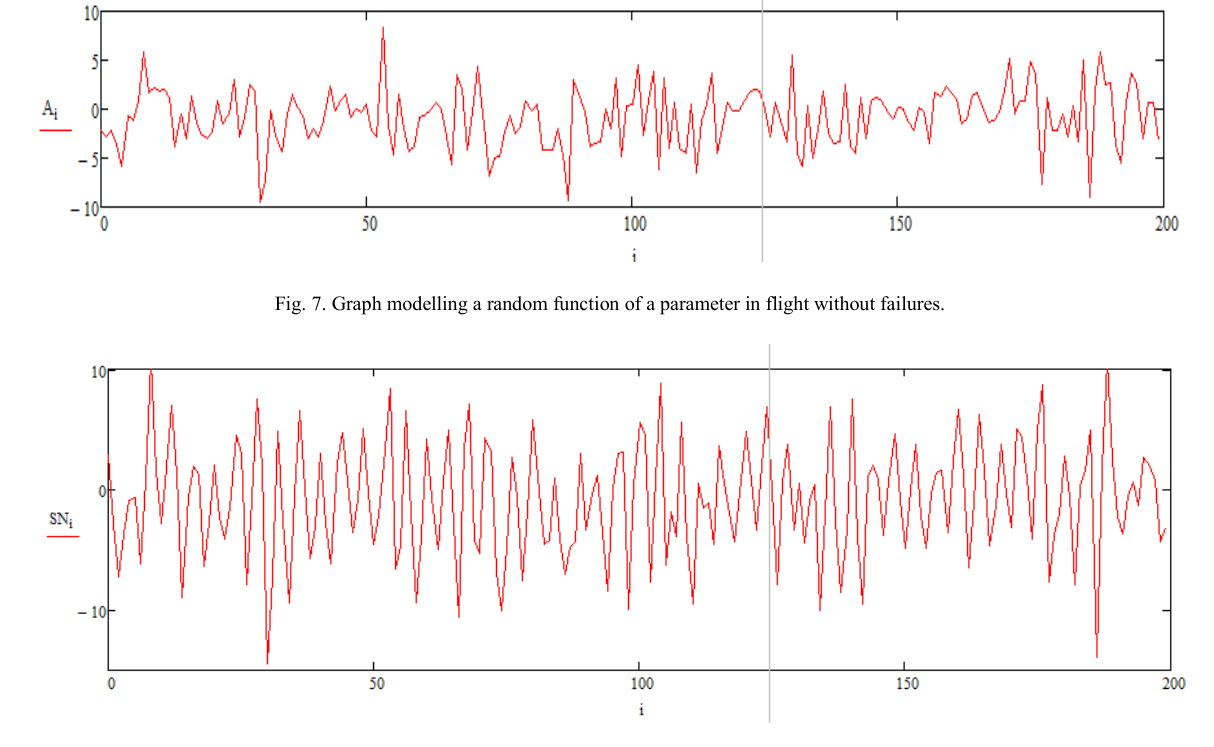
Fig. 8. Graph modelling a random function of a parameter in abnormal aircraft operation